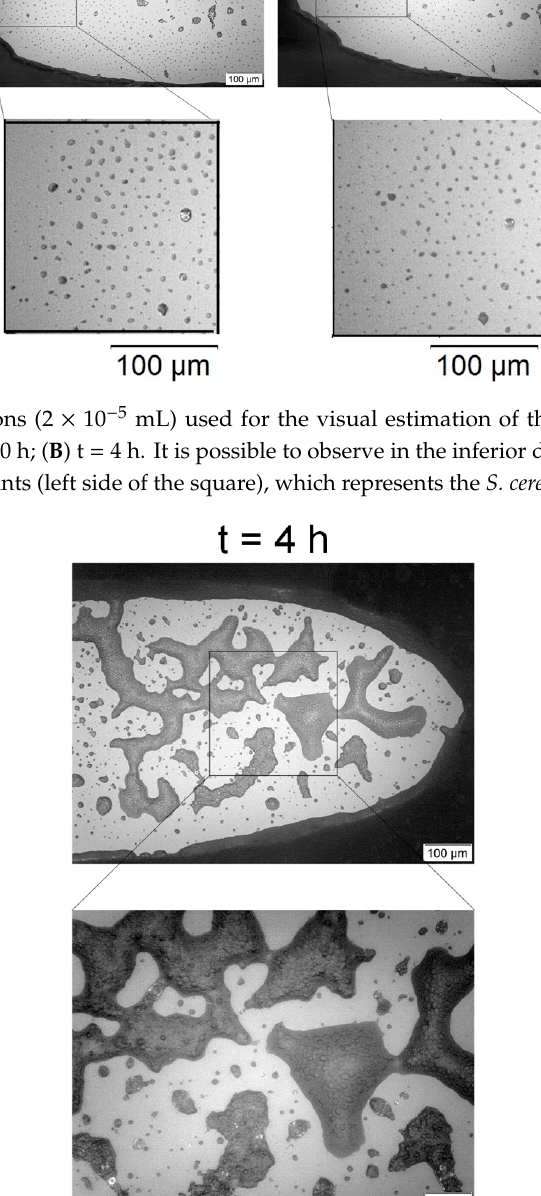
Figure 5. Region with formation of cell colonies under two magnifications, 10 × in the superior image and 20 × in the inferior image, allowing the observation of the cells’ boundaries and almost spherical morphology.